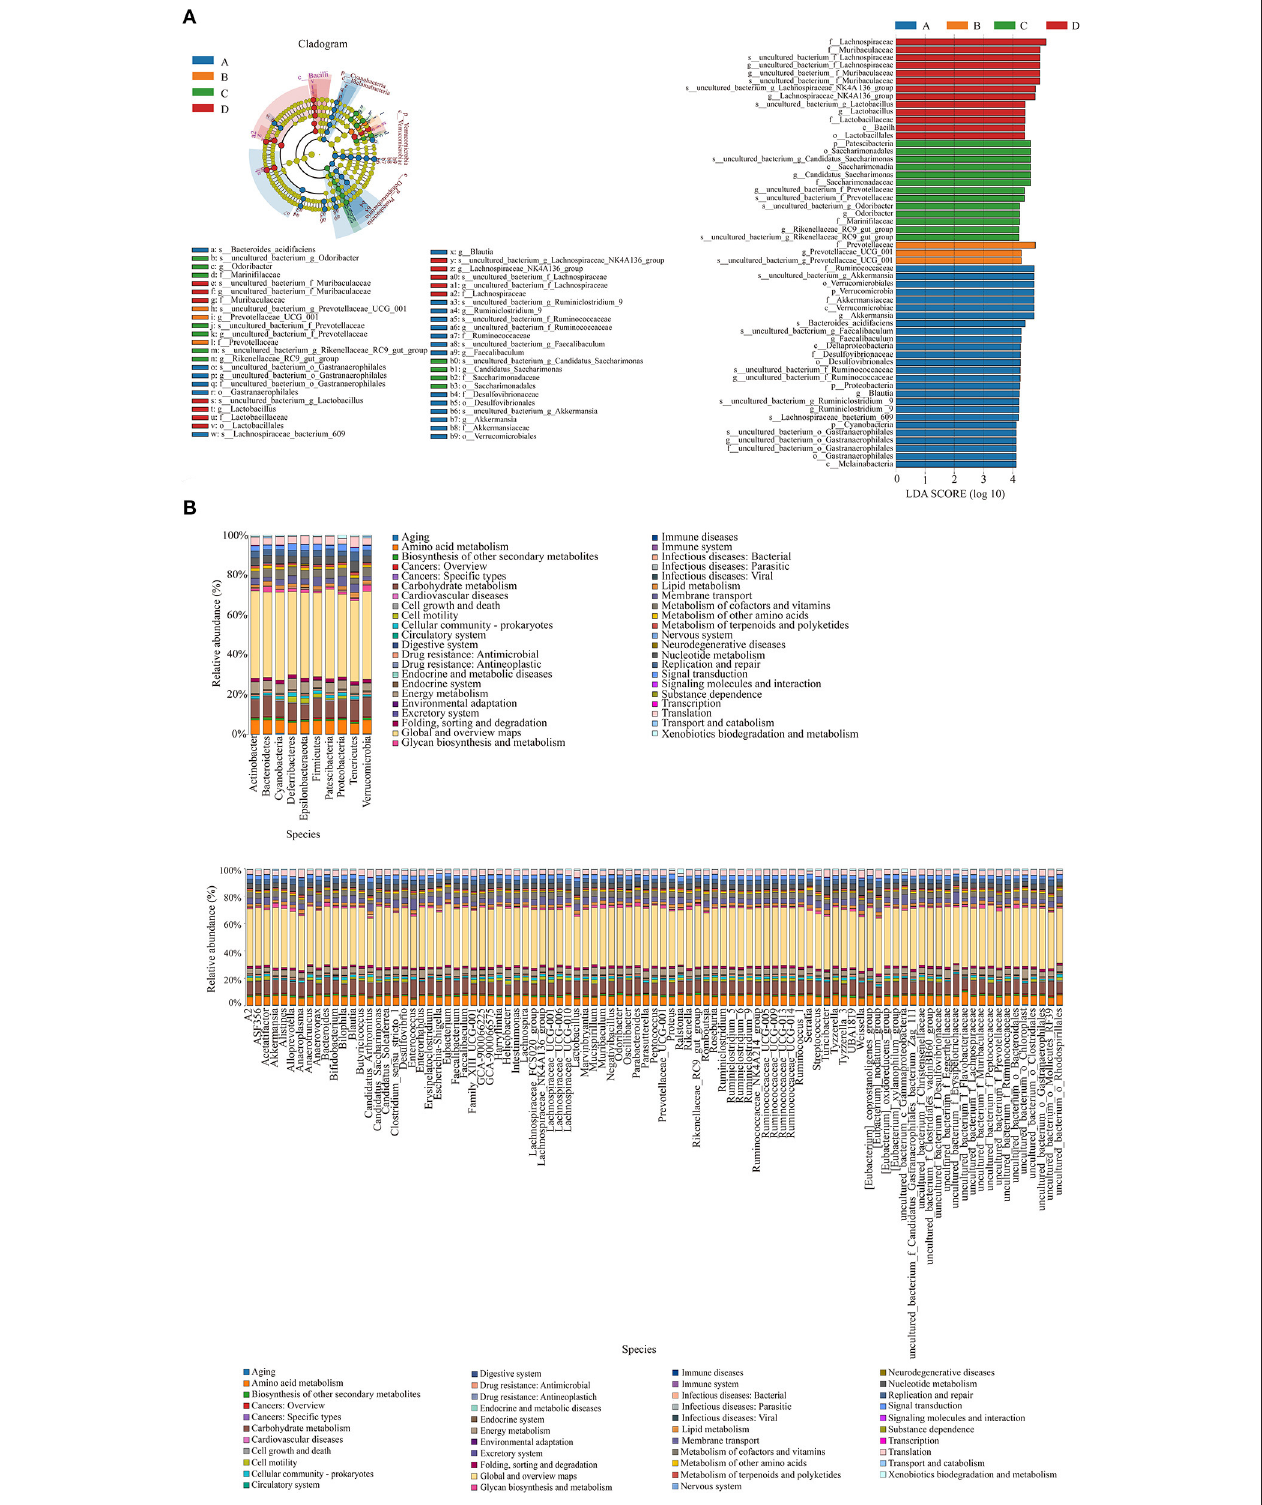
FIGURE 5 | Evolutionary branching diagram of LEfSe analysis and histogram of LDA value distribution of gut microbiota (A) and KEGG metabolic pathway histogram at phylum level and genus level (B) of functional genes of gut microbiota in SAMP8 and SAMR1 mice. A: NT-free group; B: basal diet group; C: NT intervention group;